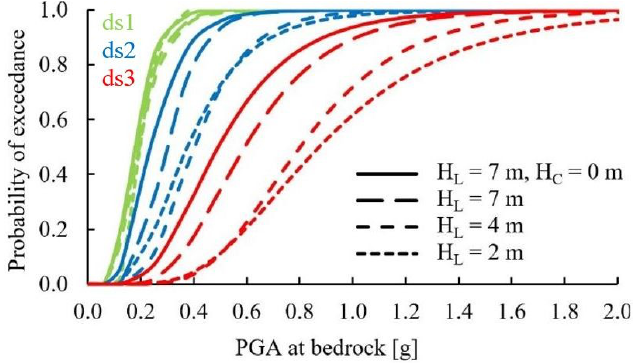
Figure 8. Influence of embankment height on fragility curves (damage state criteria for railway embankments).